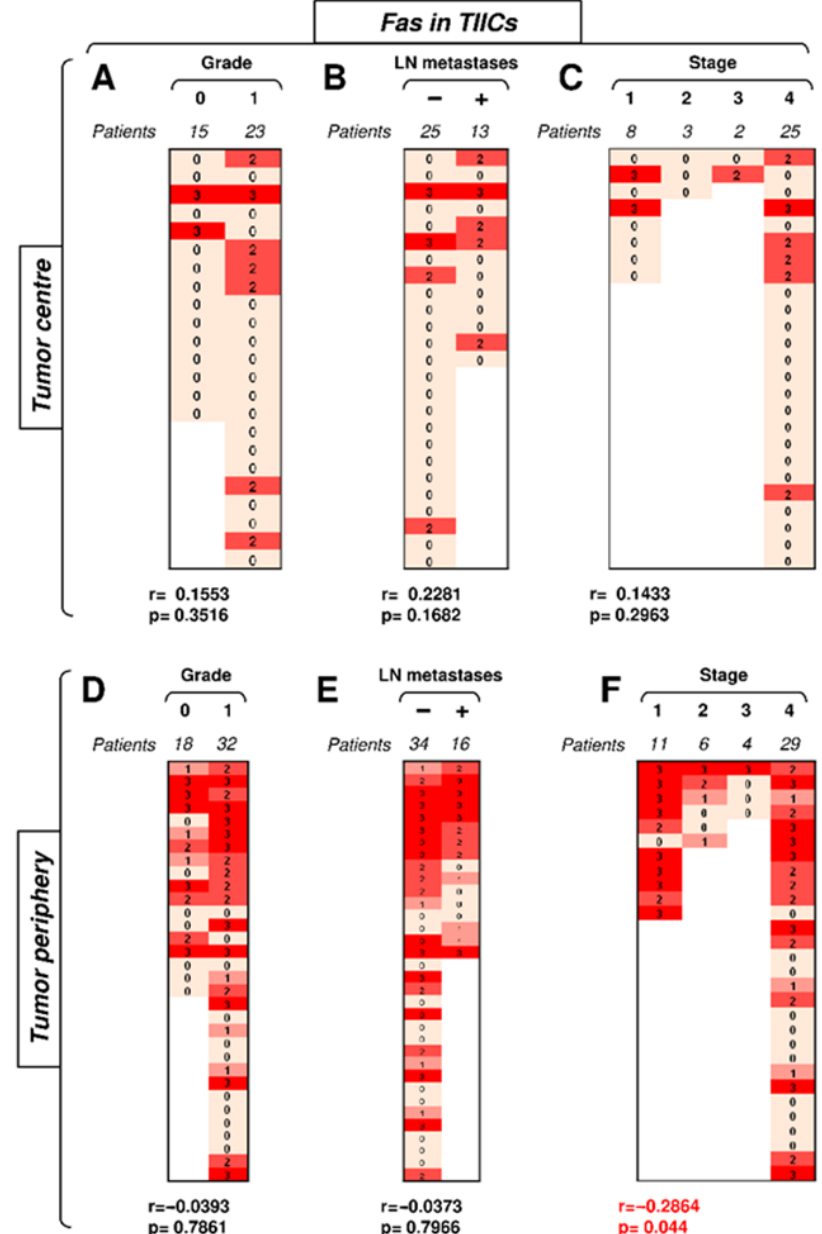
Figure 3. The expression of Fas in TIICs in the tumor periphery correlates with tumor stage. ( A ) The cohort of 38 SGC patients was stratified into 2 groups according to tumor grade (grade 0 and grade 1), and the Spearman correlation ( r ) according to the expression of Fas in TIICs in the tumor center was determined. The expression analyses were performed according to the scoring system described in the Materials and Methods section. The data are presented as a heat map with the scores, and the calculated p < 0.05 (red) was considered significant. ( B ) The patient cohort in ( A) was stratified into 2 groups according to the absence (−) or presence (+) of lymph node (LN) metastases, and the Spearman correlation ( r ) was determined as in ( A ). ( C ) The patient cohort in ( A) was stratified into 4 groups according to the primary tumor stage, and the Spearman correlation ( r ) was determined as in ( A ). (D – F ) The cohort of 40 SGC patients was stratified into groups as in ( A – C ), and the Spearman correlation ( r ) according to the expression of Fas in TIICs in the tumor periphery was determined.